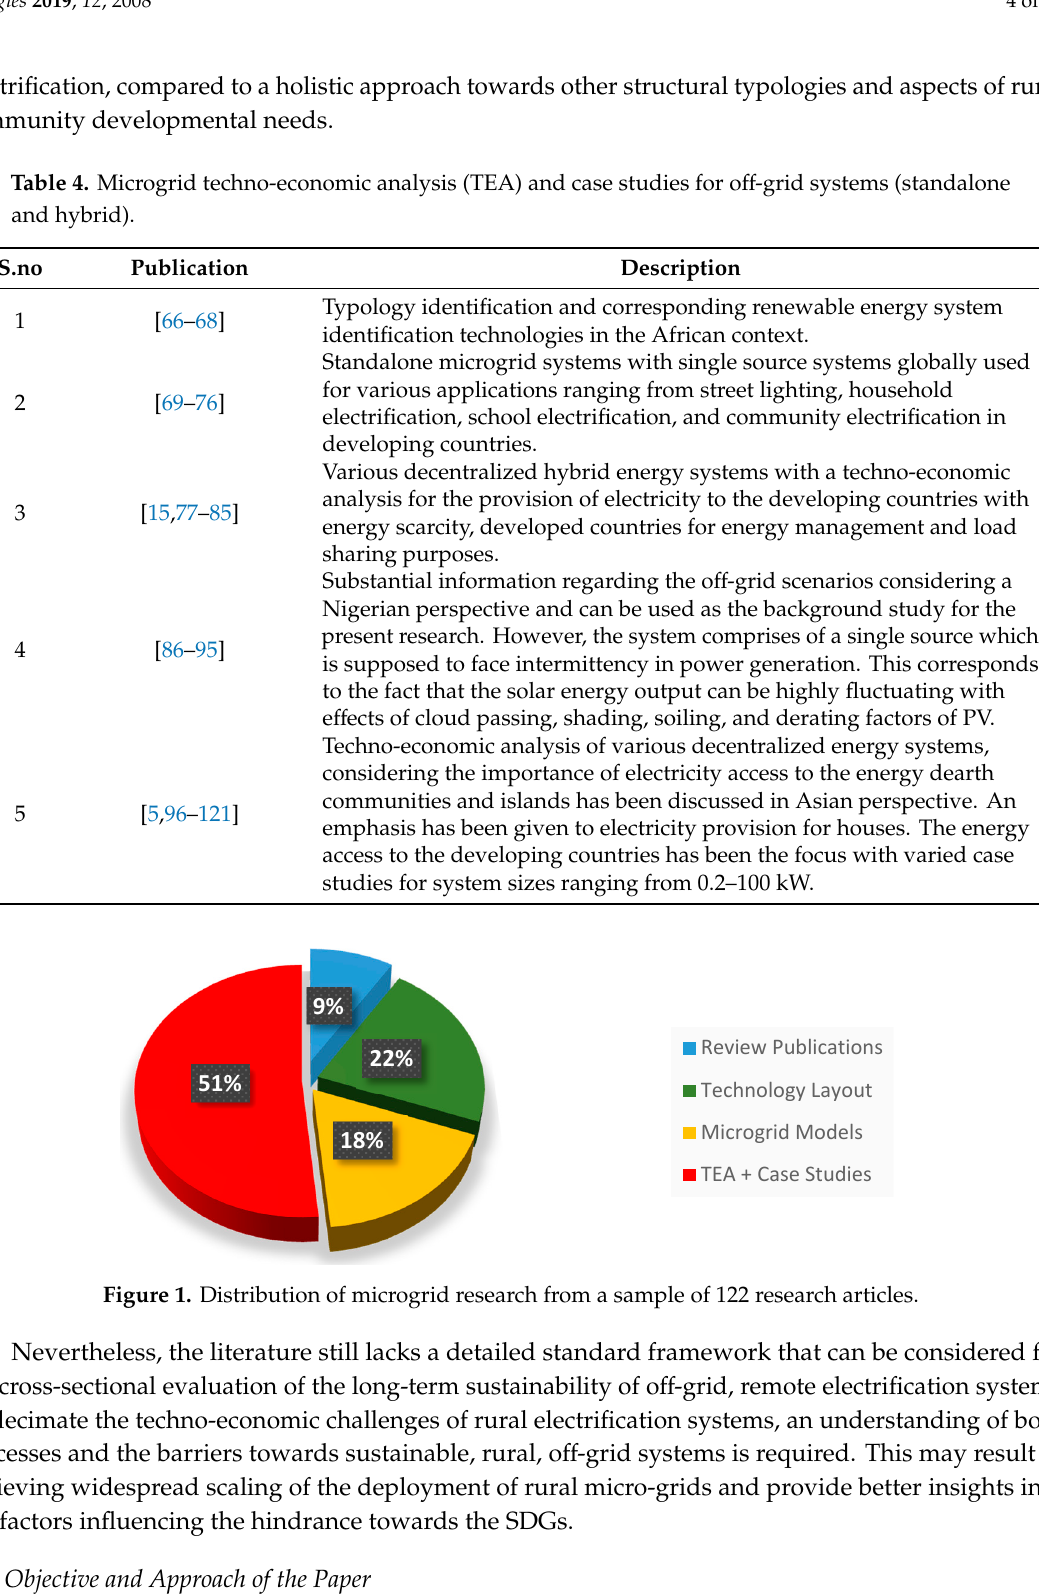
Table 4. Microgrid techno-economic analysis (TEA) and case studies for off-grid systems (standalone and hybrid).